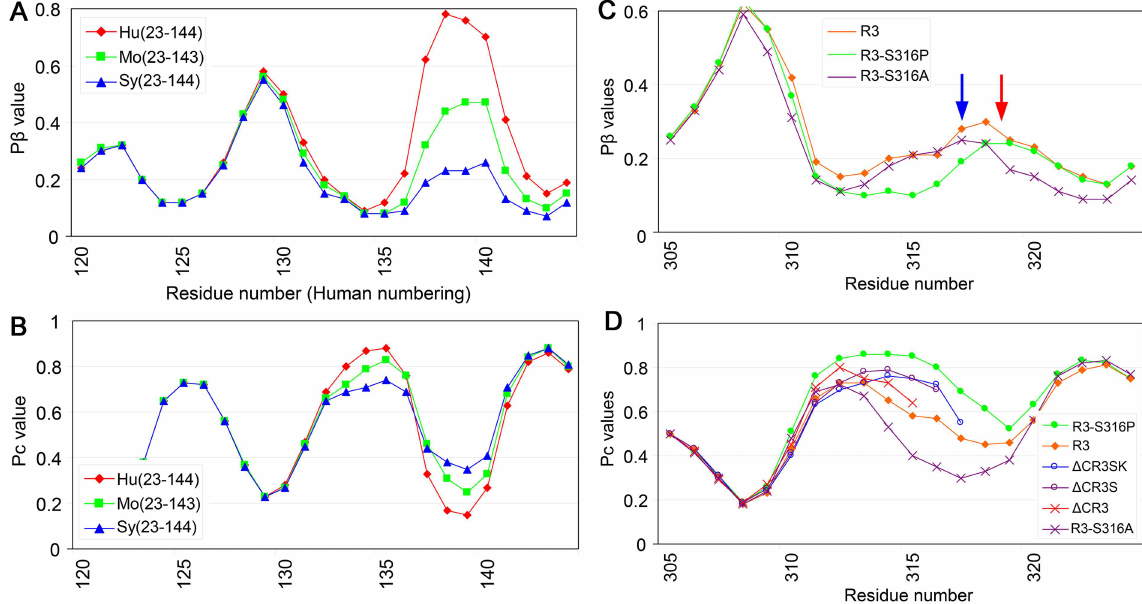
Fig 3. Smaller discrepancies in Pc values in P β trough regions are advantageous for cross-seeding of amyloids. A . P β graphsof Hu23–144and the equivalentC-terminally-truncatedmouse (Mo12–143) and Syrian hamster (Sy23–144)PrPs [15]. Hu23–140had the highestpeak at residue ~140, while Sy23–144 had the lowest and Mo23–143 had an intermediate peak. Peak heightscorrelatedwith amyloidformation efficiency, with Hu23–144beingthe most efficient, Sy23–144being the least efficient and Mo23–143 being intermediate. B . Pc graphs of Hu23–144, Mo23–143 and Sy23–144. The Pc peak at residue ~135 was locatedin a P β -troughat a positionbetweentwo P β -peaks(comparewith Fig 3A ). The Pc peak is highestin Hu(23–144),lowest in Sy(23–144) and intermediate in Mo(23–143). C . P β graphsof tau-derivedamyloidogenic peptide, R3, and its substitutionvariants, R3-S316A and R3-S316P, whose serine residue at the codon 316 was replaced with alanineor proline,respectively[16]. The two variants had P β peaks at different positions(red and blue arrows). The wide P β trough of R3-S316P might explainthe inefficiencyof fibril formation owingto the overly high freedom of motion in the loop/kinkbetweenthe two strands. D . Pc graphs of R3, the two substitutionvariants, and C-terminally-truncated variants, Δ CR3SK, Δ CR3S and Δ CR3. Δ CR3S and Δ CR3SKhave serine residues at codon316, whereas Δ CR3 lacks this codon. The curves of Δ CR3S and Δ CR3SKwere similar to those of R3-S316P, whereas the curve of Δ